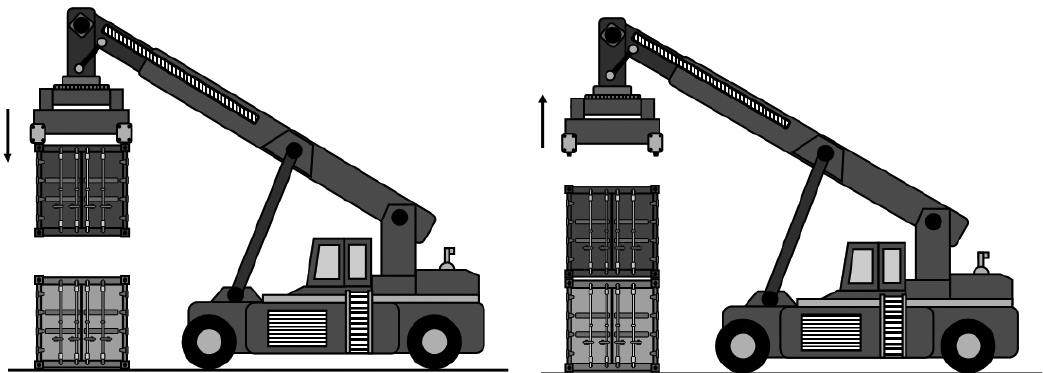
Figure 3. Operation No. 3—setting aside a large type A container on a second layer stack, within a Figure 3. Operation No. 3 – setting aside a large type A container on a second layer stack, within a prescribed sector of a storage yard. Source: own prescribed sector of a storage yard. Source: own work. Figure 3. Operation No. 3 – setting aside a large type A container on a second layer stack, within a prescribed sector of a storage yard. Source: own work. Figure 3. Operation No. 3 – setting aside a large type A container on a second layer stack, within a prescribed sector of a storage yard. Source: own work.